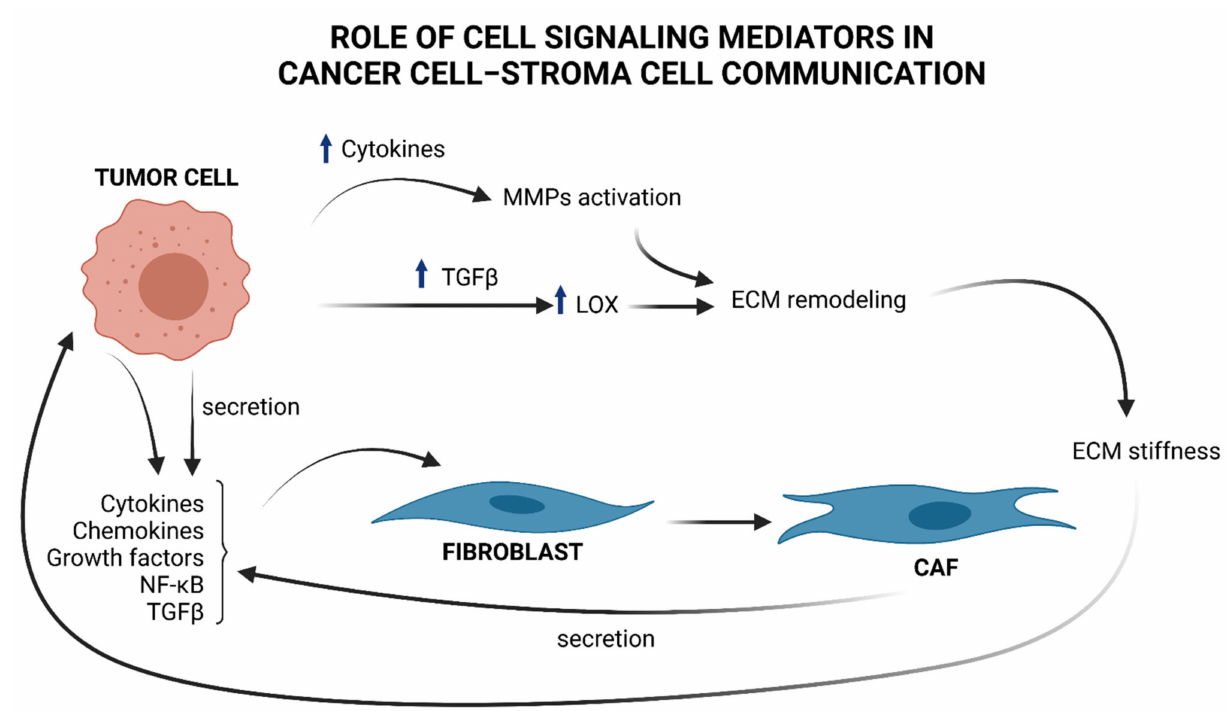
Figure 1. Brief overview of cell signaling mediators in cancer cell–stroma cell communication and ECM remodeling. Tumor cells produce cytokines, chemokines, NF- κ B, and TGF β , that “activate” stromal progenitors, such as fibroblasts, into CAFs and produce, in turn, cytokines and TGF β , influencing tumor cell functions. TGF β upregulation in cancer cells provokes an increment in LOX, which in turn affects ECM remodeling by changing the collagen organization and provoking ECM stiffness that induces the mechanical activation of latent TGF β . An increased amount of cytokines by tumor cells induces MMPs activation that contributes to ECM remodeling and sustains tumor